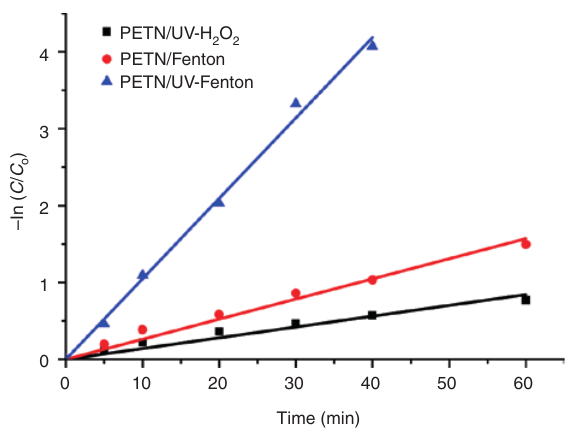
) vs. time in different systems. Figure 4: The − ln( C/C o PETN/UV-H O ; PETN/Fenton; PETN/UV-Fenton; [PETN] 2 2